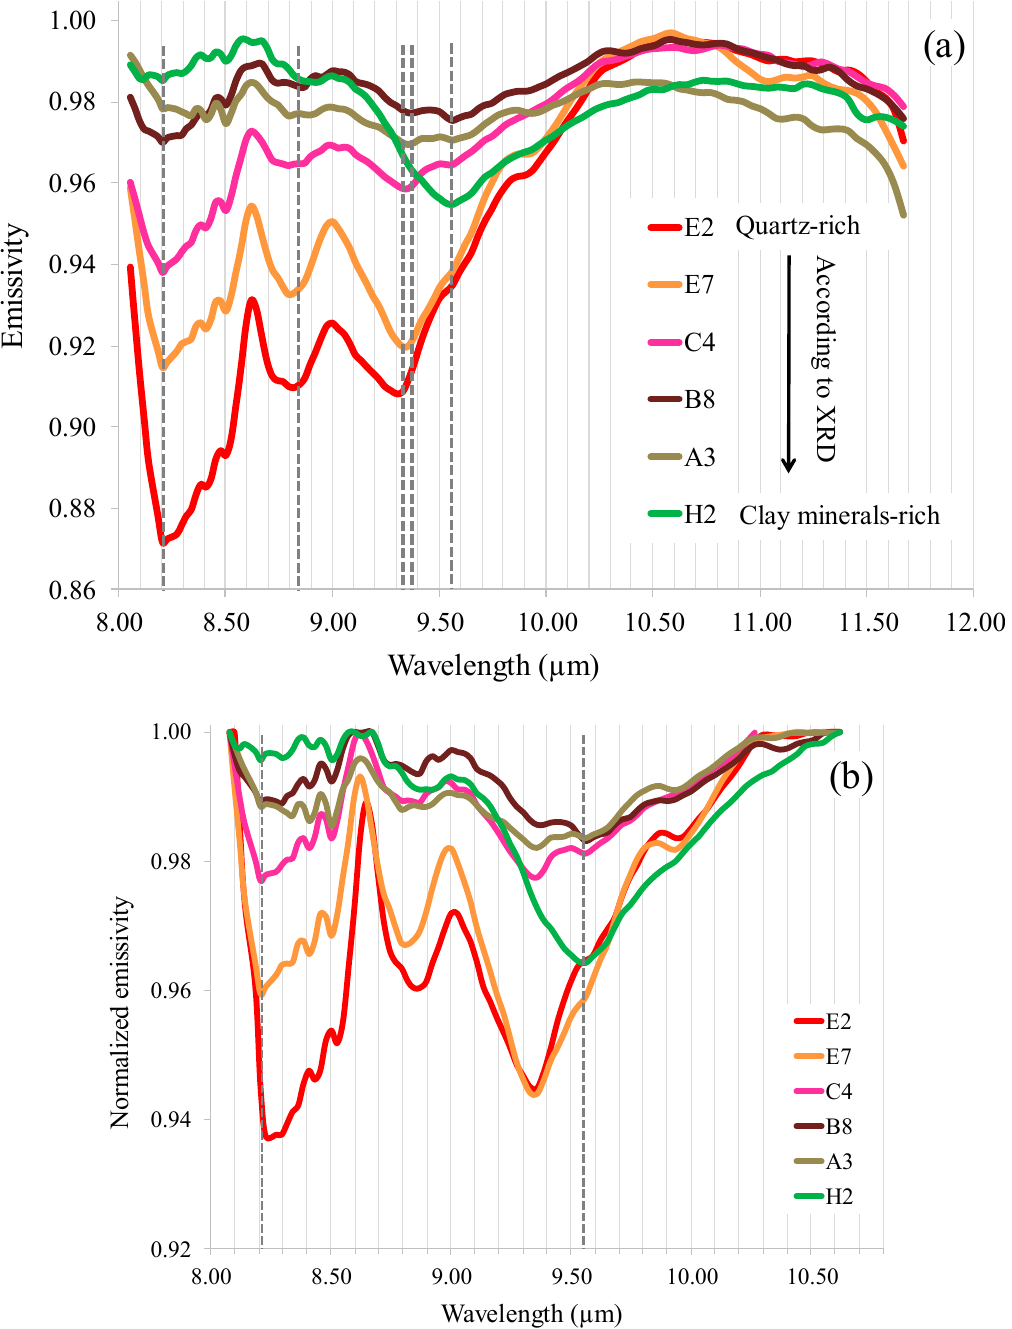
Figure 2. ( a ) Emissivity spectra of selected soil samples. Each spectrum is the average of tens of pixels in the calculated emissivity image. ( b ) Normalized emissivity spectra emphasizing indicative absorption features of quartz and clay minerals. Gray dashed lines emphasize the wavelengths mentioned in the text.